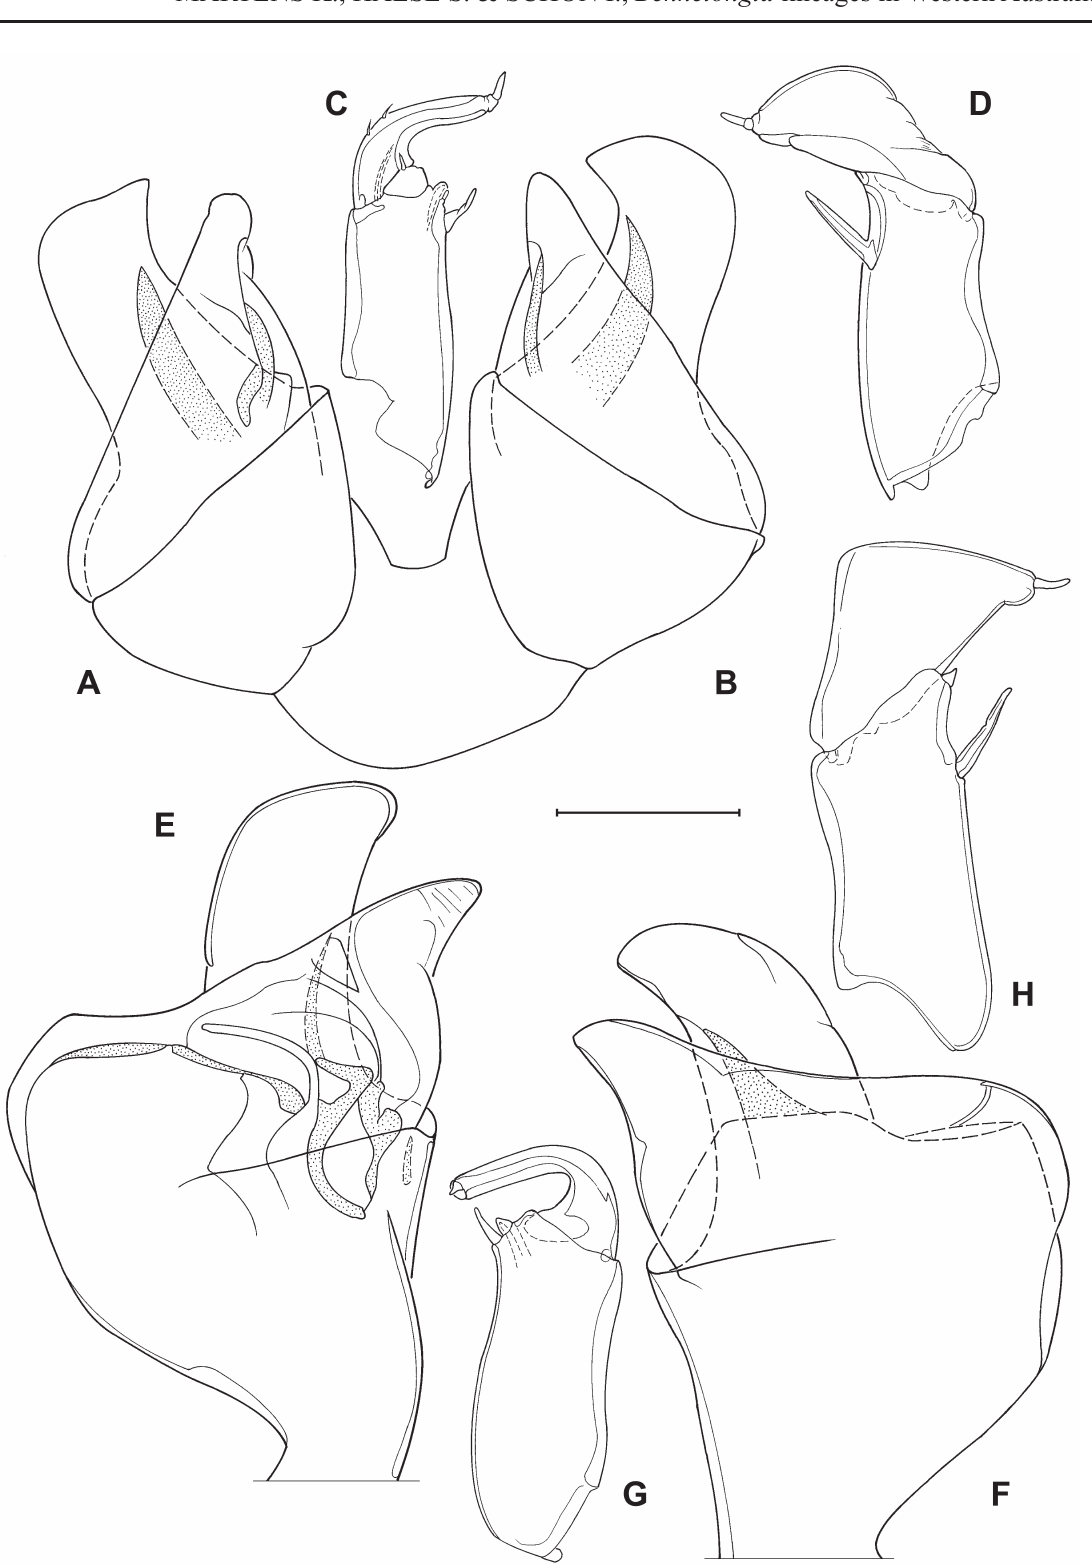
Fig. 6. Bennelongia tirigie sp. nov. (A–D, WAMC55595, holotype) and B. koendersae sp. nov. (e– H, WAMC55615, paratype), all ♂. A–B . Outlines of hemipenes. C . lpp. D . rpp. E – F . Outlines of hemipenes. G . lpp. H . Rpp. Scale = 73 µm for A, D–E; 31 µm for B–C,